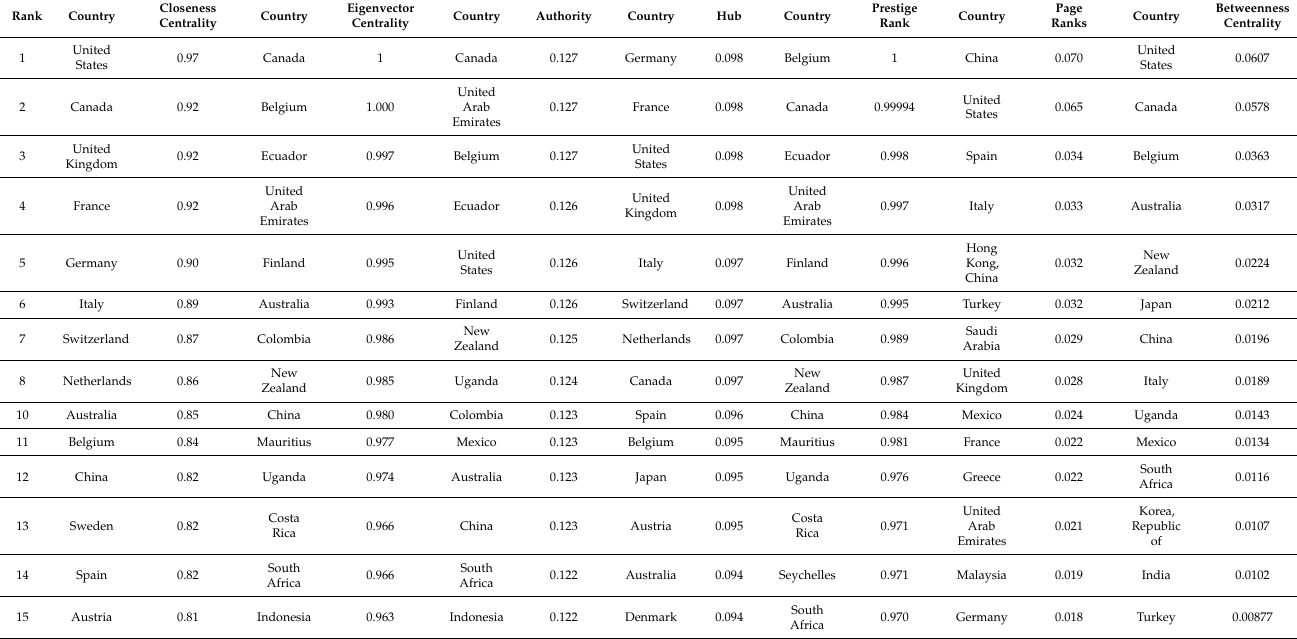
Table A2. Top 10% countries ranked by centrality